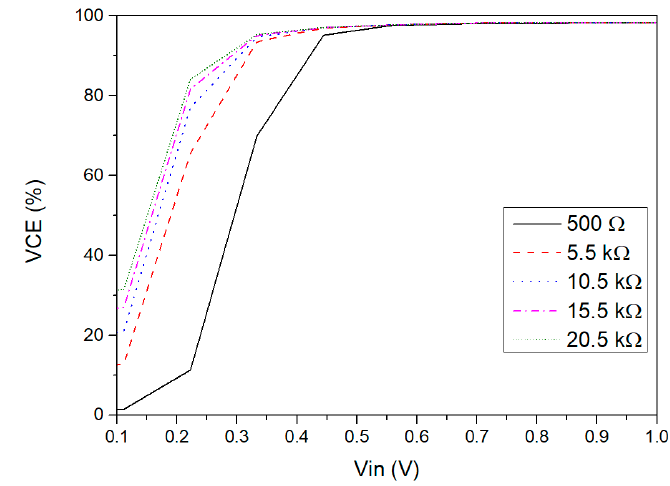
Figure 5. VCE versus input voltage amplitude simulated for different ohmic loads.